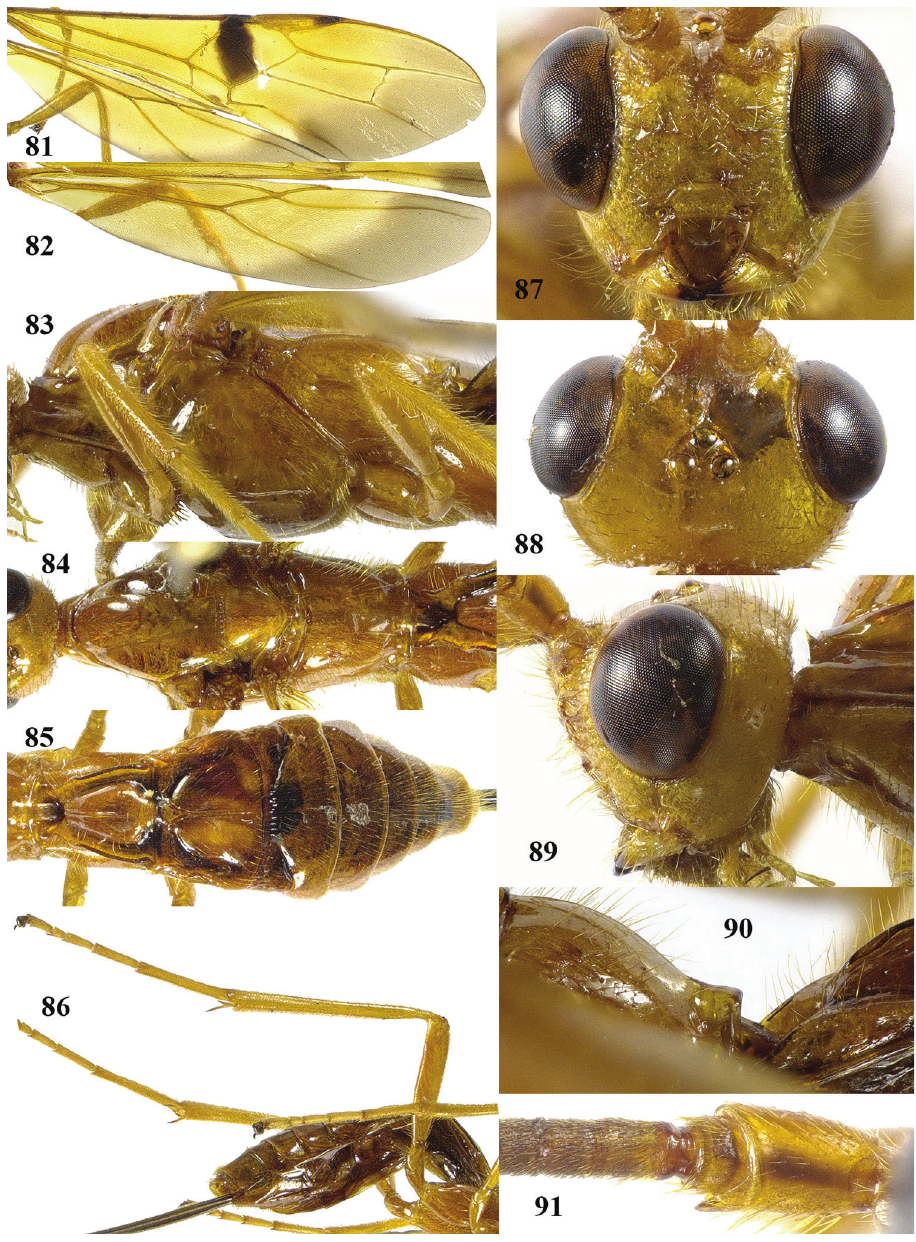
Figures 81–91. Maculibracon simlaensis (Cameron), ♀ , Vietnam. 81 fore wing 82 hind wing 83 meso- soma lateral 84 mesosoma dorsal 85 metasoma dorsal 86 hind leg lateral 87 head anterior 88 head dorsal 89 head lateral 90 propodeum lateral 91 scapus outer side